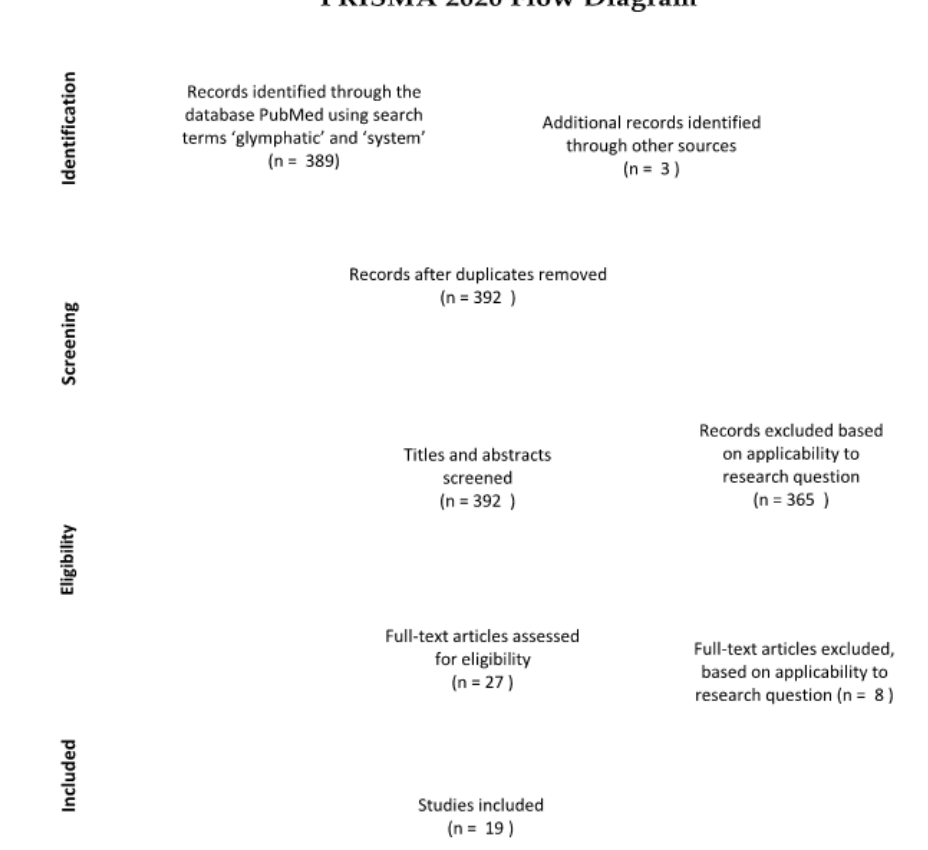
Figure 1. (Figure 1. was created according to the guidelines [9] p. 3). Of the 389 papers obtained, ultimately only 19 were included in the final literature